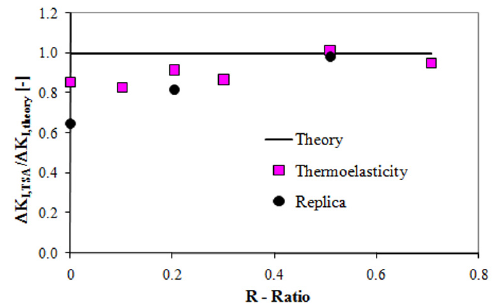
Figure 4: Theoretical, experimental TSA and replica  K I values against R –